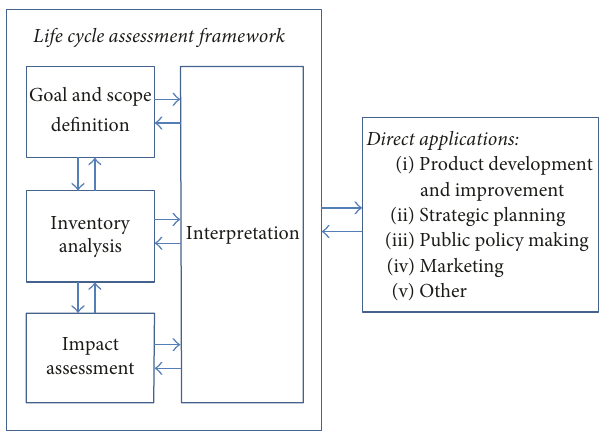
Figure 5: Stages of a life cycle assessment according to DIN EN ISO 14040 [15, p.